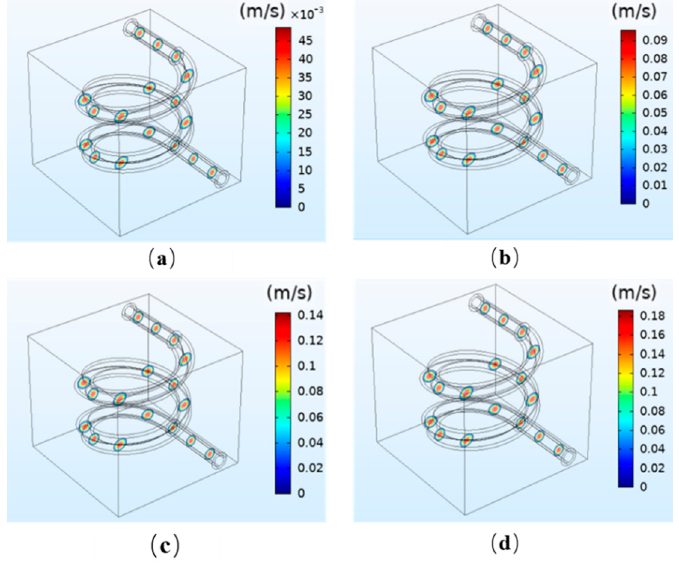
Figure 3. Simulation results of the fluid velocity under different perfusion pressures: ( a ) 12 mmHg; ( b ) 13 mmHg; ( c ) 14 mmHg; ( d ) 15 mmHg.